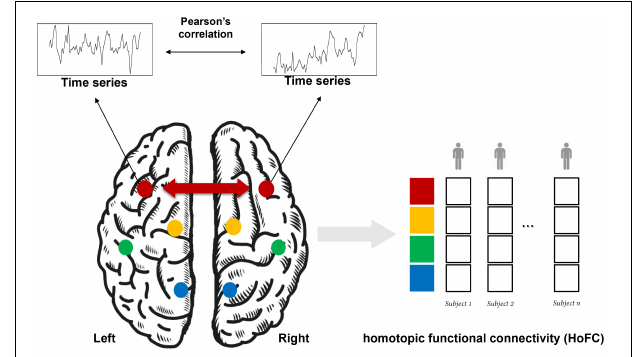
FIGURE 1 | A schematic flowchart of the definition of homotopic functional connectivity (HoFC). The homotopic pair could be mirrored voxels or